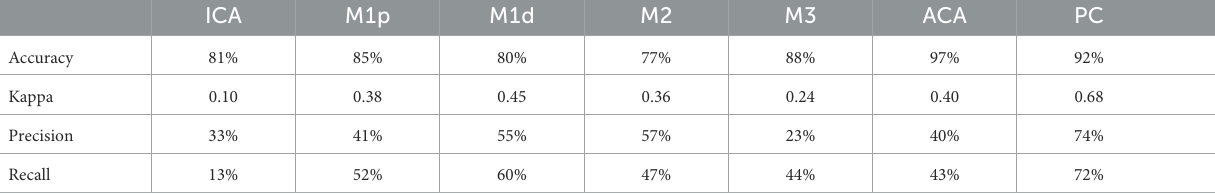
TABLE 3 The accuracy, Cohen’s kappa, precision, and recall for each vessel occlusion